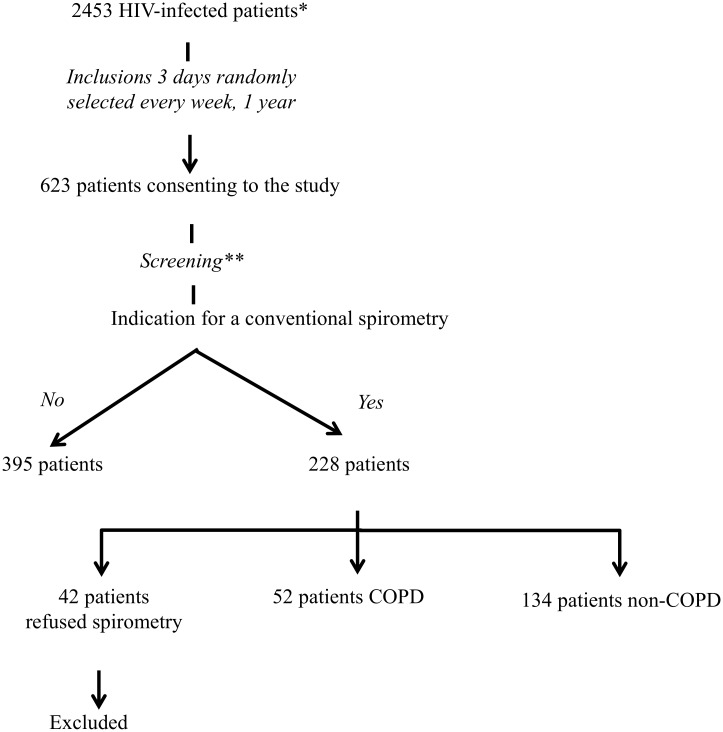
Study’s flowchart.* Cohort of HIV-infected patients consulting in infectious department during 1 year. ** Dedicated questionnaire + Hand-Held spirometer.